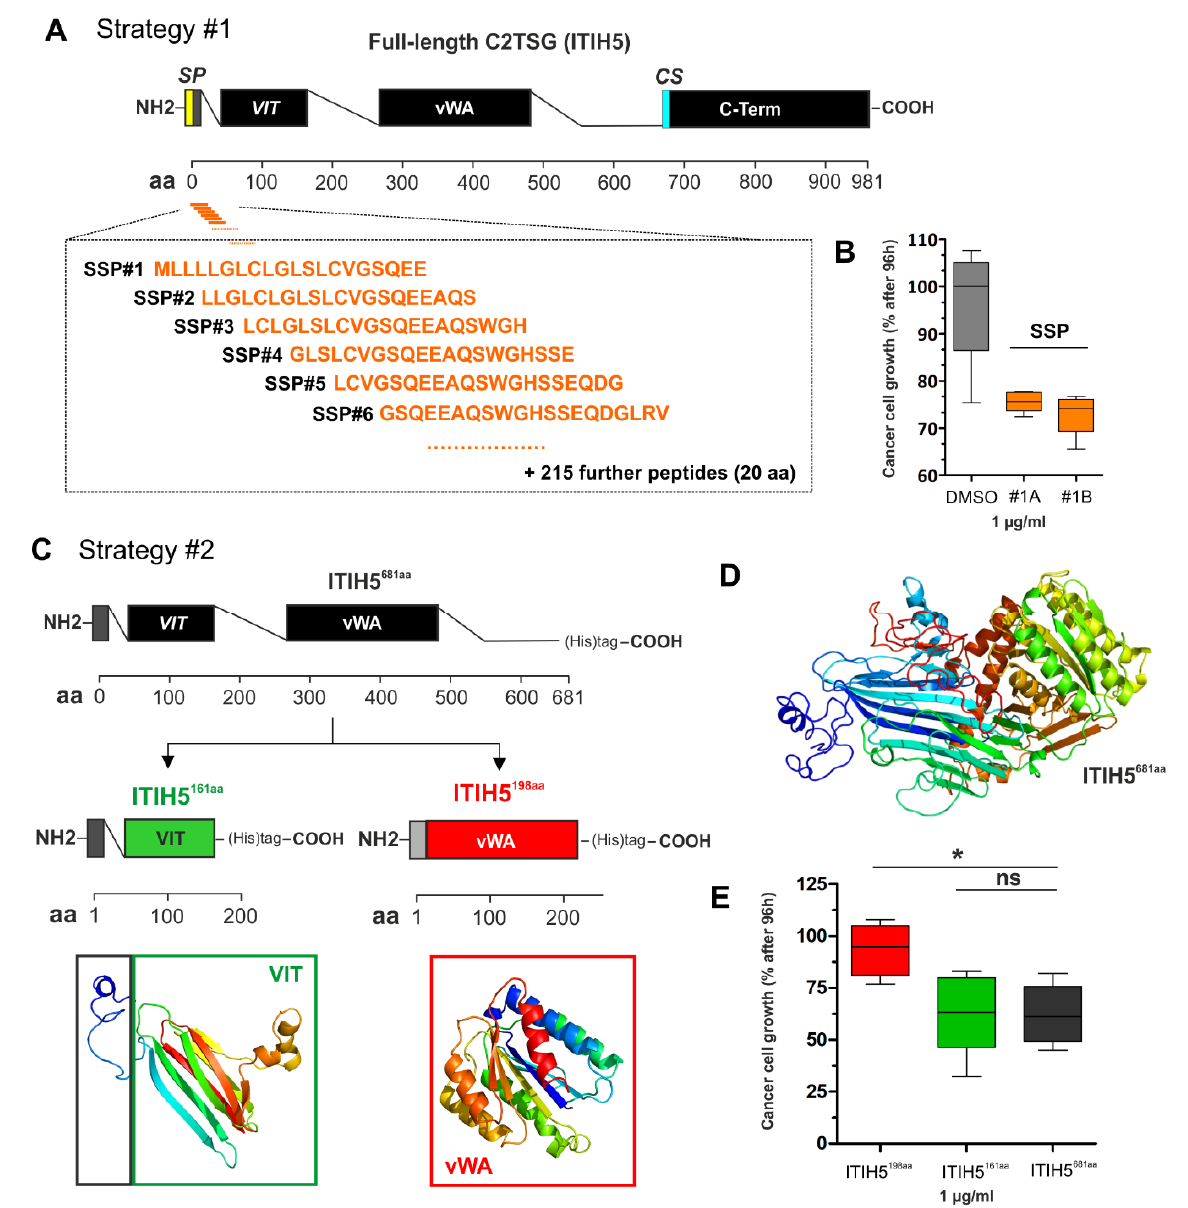
Figure 4. Illustration of the two strategies to engineer mimetics of C2TSG protein based on the ITIH5 example. ( A ) Strategy #1: Schematic cartoon of the full-length ITIH5 protein consisting of 942 amino acids (942 aa), including an illustration of the relative position of synthetic peptides (overall n = 221) covering the N-terminal protein part, i.e., from the signal peptide (SP, aa #1) to the conserved cleavage site (CS, aa #680). VIT: Vault protein inter-alpha-trypsin, vWA: von Willebrand factor, type A, C-term: Inter-alpha-trypsin inhibitor heavy chain, C-terminal. ( B ) Growth of breast cancer cells upon in vitro treatment with peptides #1A and #1B (each 1 µg) compared with the DMSO control using the XTT proliferation assay. ( C ) Strategy #2: Engineering of truncated and recombinant polypeptides either covering the VIT domain (relative aa position according to specific databases: PFAM = 51–159; Prosite profiles = 35–161) (including the endogenous SP) or the vWA domain (relative aa position: PFAM = 295–466; Prosite profiles = 295–478). ( D ) The three-dimensional structure of the N-terminus, the VIT, and vWA polypeptides were predicted and visualized by using Phyre 2 tool [44]. ( E ) Growth of breast cancer cells upon extracellular application of recombinant polypeptides (VIT and vWA, 1 µ g) compared with the recombinant N-terminal ITIH5 protein by determining the living cell numbers 96 h after treatment. (ns: not significant, *: p <